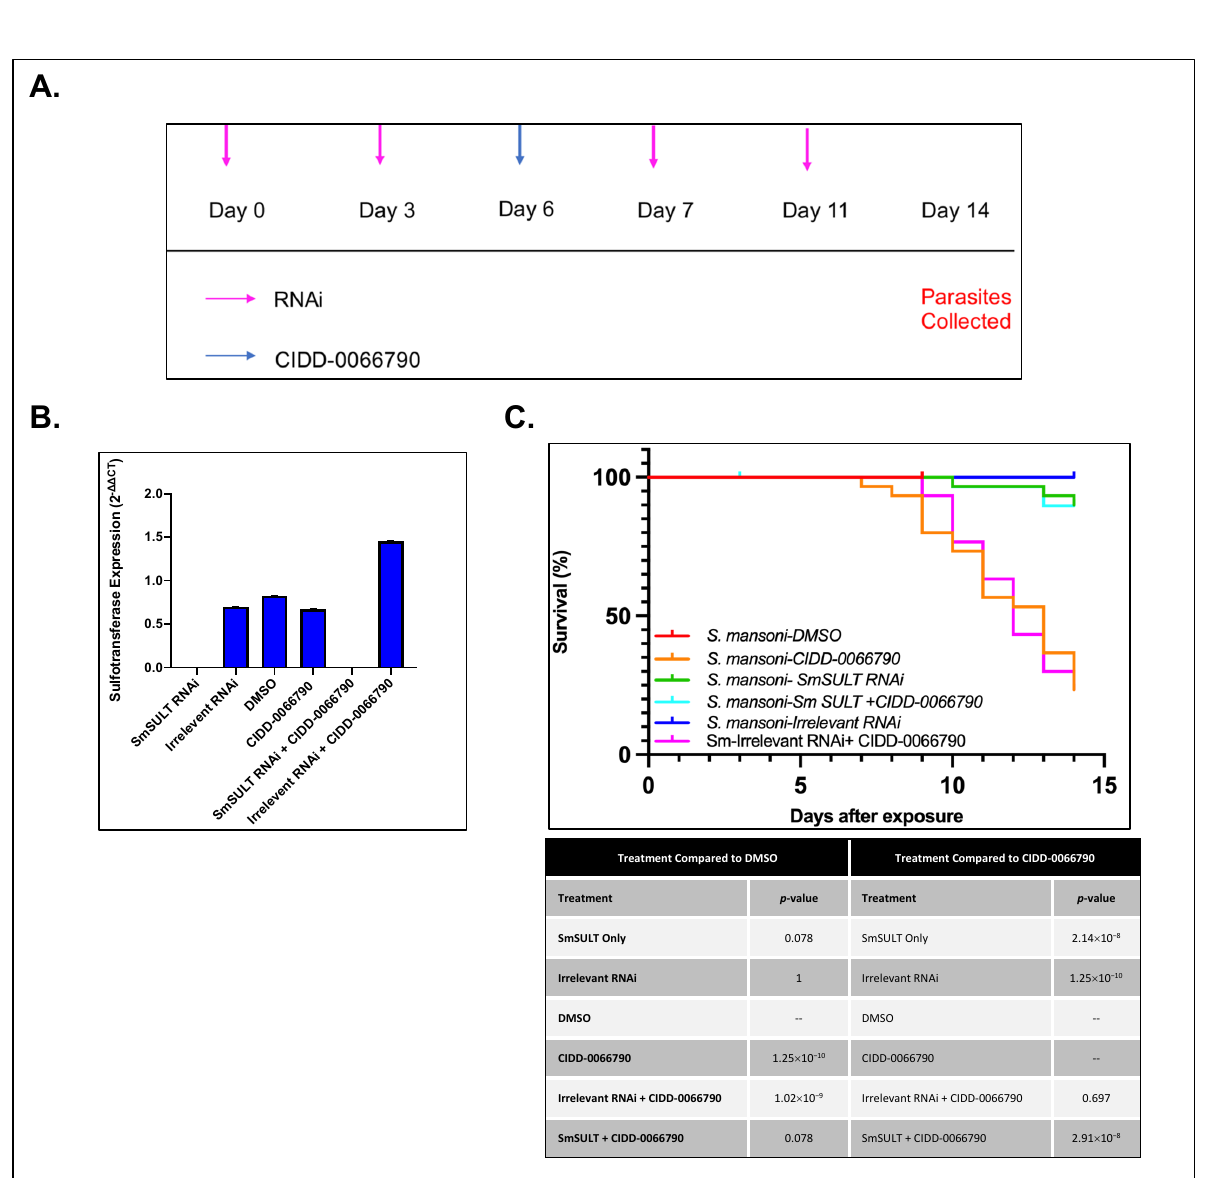
Figure 2. Silencing of S. mansoni sulfotransferase results in resistant parasites upon challenge with CIDD-0066790. ( A ) RNAi treatment schematic. Adult male parasites were sorted, 10 per well, on day 0 and subsequently treated with 30 µg/mL of RNAi per mL of media. RNAi was supplemented every other day, as highlighted with pink arrows. On day 6, parasites were treated with CIDD-0066790 (blue arrow) at a final concentration of 143 µM. Parasites were incubated with drug for 45 min. After 45 min, parasites were washed 3 times with DMEM + 10% FBS to wash any residual compound. After 14 days, the parasites were collected and quick frozen for RNA isolation. ( B ) SmSULT -specific knockdown using RNA interference. Quantitative PCR (qRT-PCR) was conducted to confirm gene silencing of S. mansoni sulfotransferase ( SmSULT ). Gene expression in SmSULT RNAi group was significantly reduced by about 99% when compared to other treatment groups. GAPDH was used as the endogenous control. There was a no-treatment group that was just male worms (not shown), which was used as the control, which was the sample that was set to 1. ( C ) Survival curve analysis of adult male S. mansoni parasites exposed to CIDD-0066790. Irrelevant RNAi, SmSULT RNAi alone, and SmSULT RNAi + CIDD-0066790 had 90%+ survival and were displaying healthy characteristics (no signs of blebbing, and internal vacuolization) and